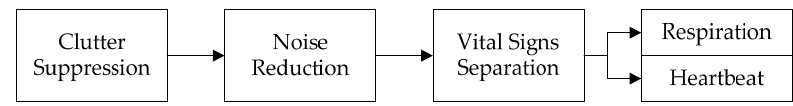
Figure 2. Flowchart of the proposed detection method.